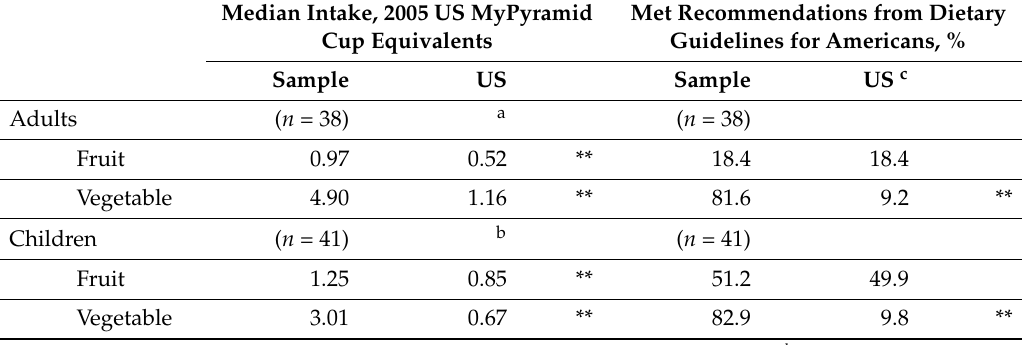
Table 2. Total fruit and vegetable intake (FVI) in a cohort of 41 low-income households that participated in cost-offset community supported agriculture